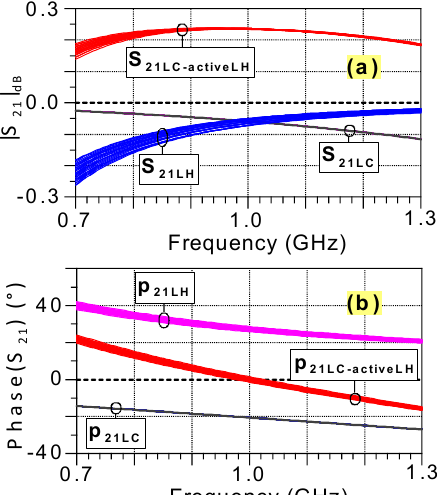
Figure 4: Magnitudes (a) and phases (b) of the LC, LH-cell and compensated circuit transmission parameters.